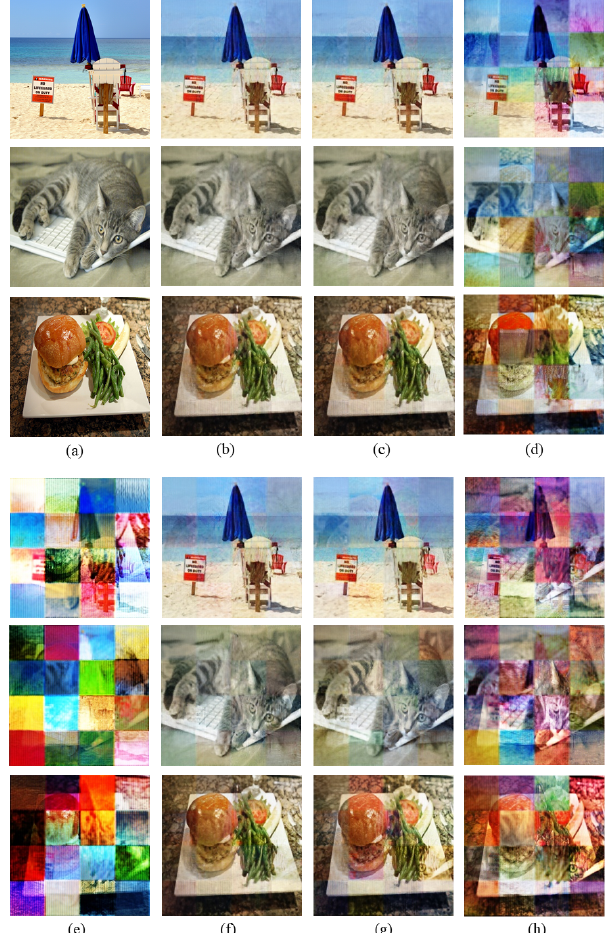
Figure 6. Results of inserting private key ( K p ) with noise when N = 3. ( a ) Original secret images. ( b ) Results from noise-free private keys. ( c – e ) Results from private keys with Gaussian noise ( σ = 0.1, 1, 3). ( f – h ) Results from private keys with S&P noises (density = 5%, 10%,